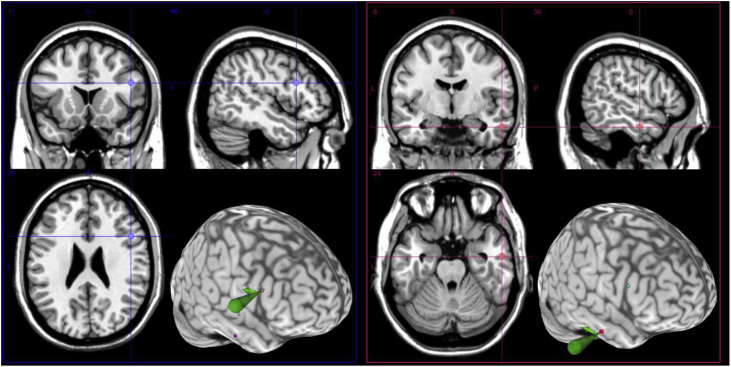
Target stimulation sites pinpointed on the MNI cortical template. Blue represents the right MFG. Red represents the right ATL.